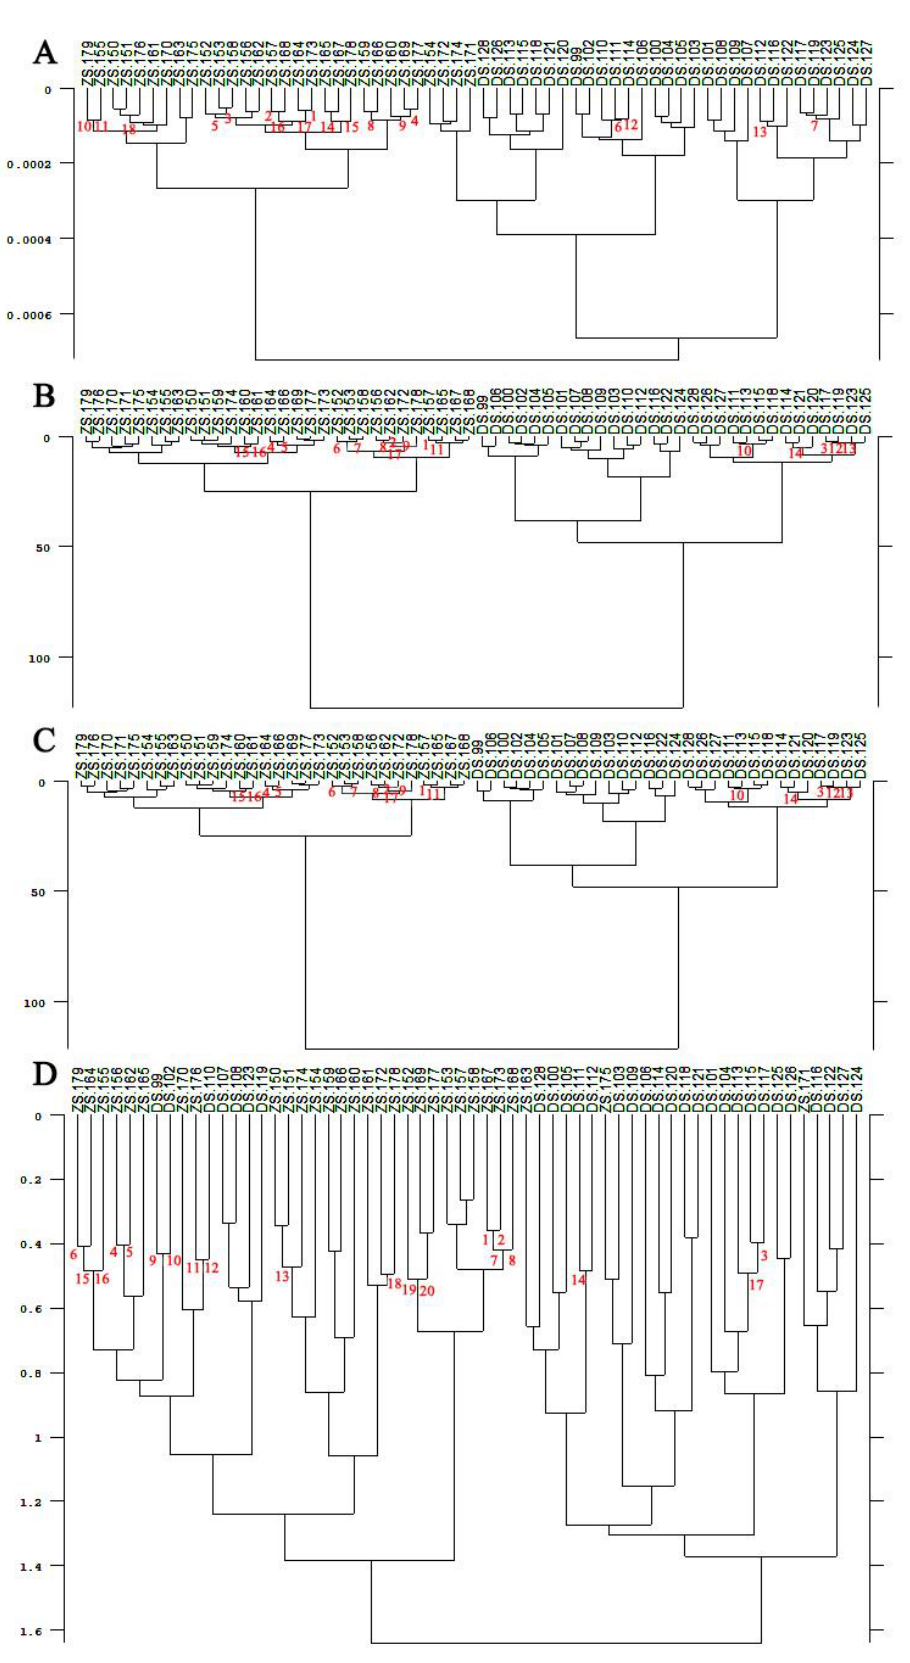
Figure 6. Tree shape of pear fruit clustering analysis from the Pucheng Pear Experimental Demon- stration Station. ( A ) Standard algorithms; ( B ) First range calibration methods; ( C ) Reproduction level normalization methods; ( D ) Factorial methods.